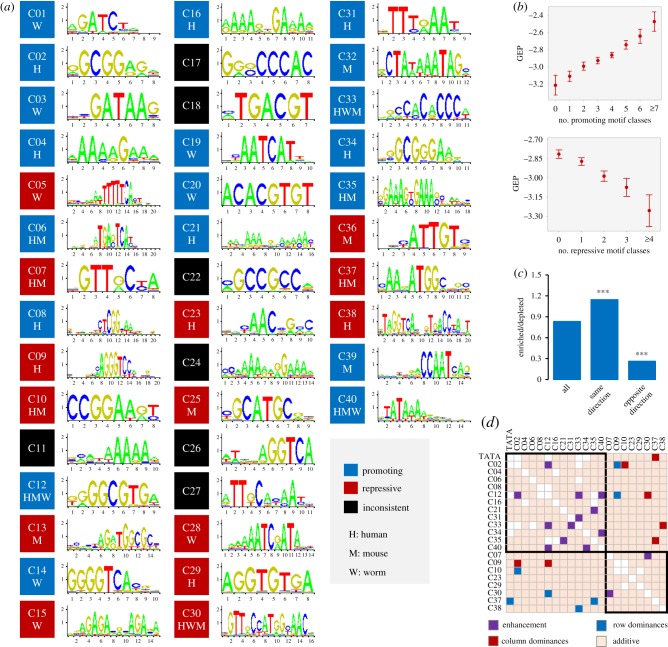
Influence of promoter elements on GEP. (a) The figure shows the sequence logo and effects of motif classes associated with GEP. Black indicates motif classes with inconsistent effects; blue and red indicate the 33 motif classes that have GEP-promoting or -repressive roles in corresponding species, respectively. Because individual motifs within motif classes exhibit high sequence similarity, representative motif sequence logos are used. (b) Cumulative effects of motif classes on human GEP. The figure summarizes the changes in GEP as more GEP-promoting (top) and -repressing (bottom) motif classes occur in gene promoters. See electronic supplementary material, figure S3c for results from mouse and worm. (c) Optimization of motif co-occurrence in human promoters. Co-occurrence was evaluated for all motif pairs that affected GEP in the same or opposite directions. A motif pair was considered enriched or depleted if their observed co-occurrence was significantly higher or lower than expected (Fisher's exact test, p < 0.05), respectively. *** denotes a ratio significantly different from that of all motif pairs (Fisher's exact test, p < 0.001). See electronic supplementary material, figure S3d for results from mouse and worm. (d) Combinatorial effects of DNA motifs on human GEP. Matrix shows additive (light orange), enhancement (purple) and dominance (blue and red) relationships between all pairwise motif classes. Black boxes highlight motif classes that affect GEP in the same direction. See electronic supplementary material, figure S3f for results from mouse and worm.